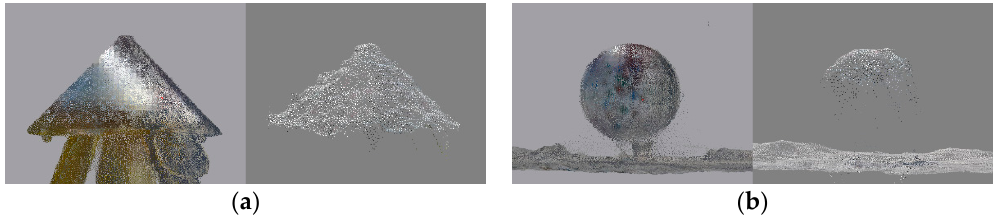
Figure 18. ( a ) Cone in the TLS point cloud (left) and noise-distorted cone in the UAV point cloud (right); ( b ) large sphere in the TLS point cloud (left) and flattened large sphere in the UAV point cloud (right).